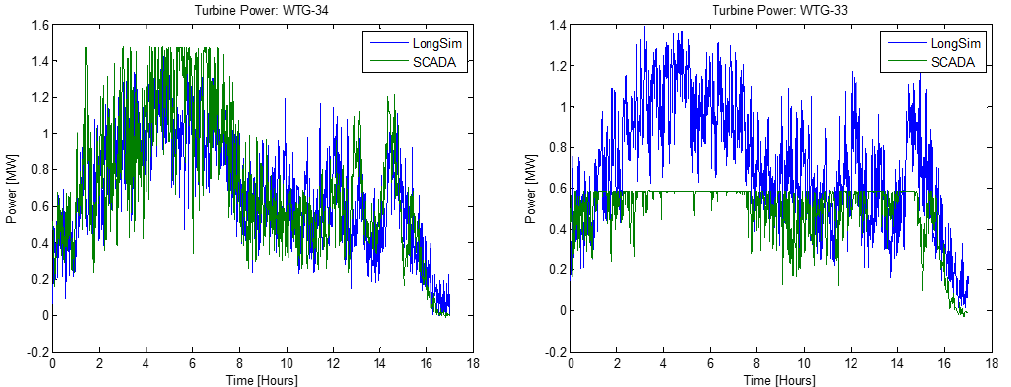
Figure 13. Measured and simulated power at turbine nos. 34 and